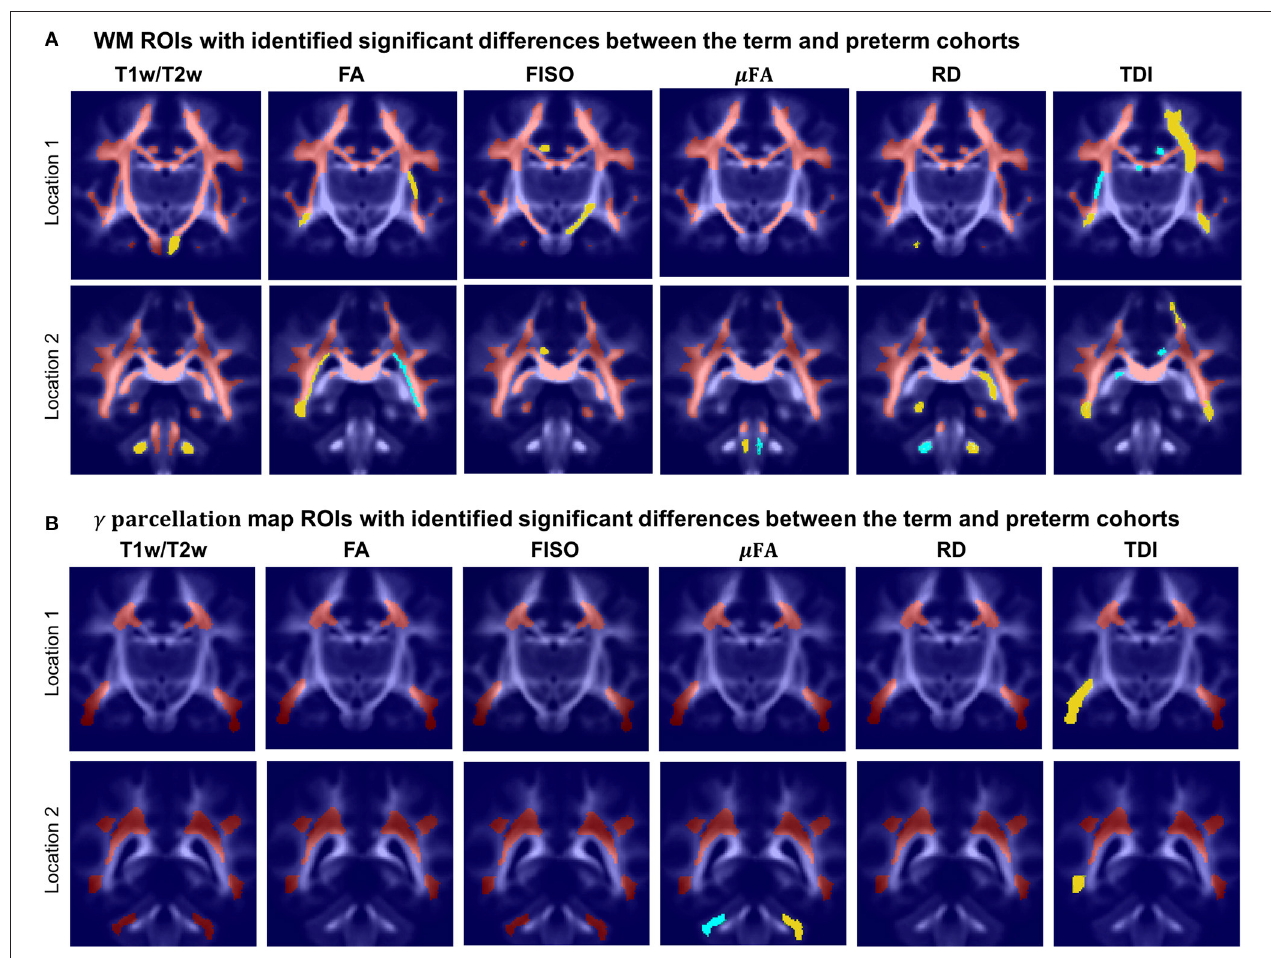
FIGURE 14 | Atlas-based region-specific analysis. The regions significantly associated with GA at birth are highlighted with red ( p < 0.001), yellow ( p < 0.01) and cyan ( p < 0.05) and overlaid over the averaged TDI map in two coronal view locations. (A) WM parcellation regions. (B) γ av parcellation